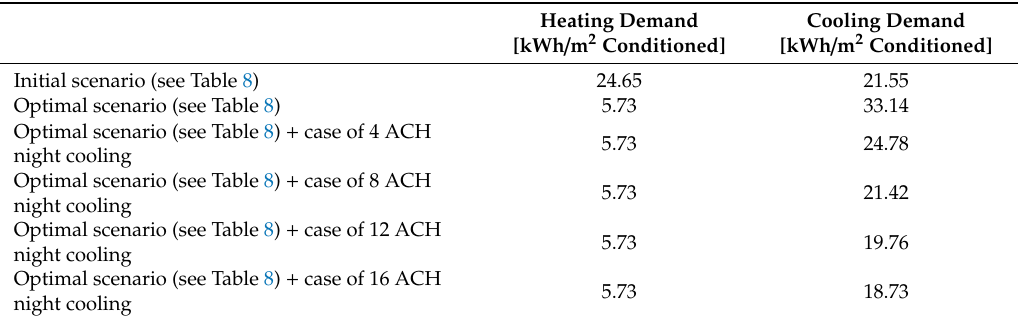
Table 9. Final results of improvements. Figure 12. Example of CFD results: analysis of flow patterns.